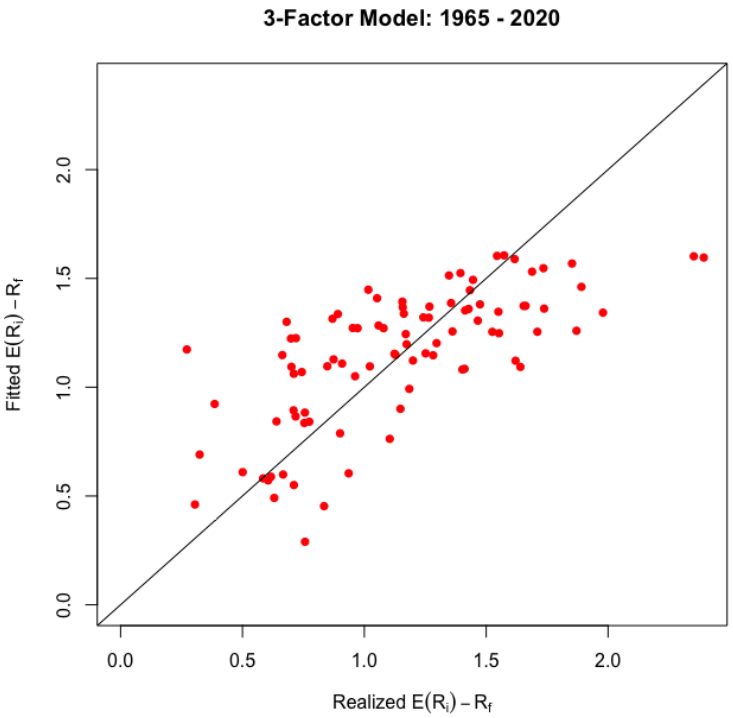
Figure 8. Out-of-sample cross-sectional relationships for the Fama and French three-factor model between average one-month-ahead fitted (predicted) excess returns in percent ( y -axis) and average one-month-ahead realized excess returns in percent ( x -axis): January 1965 to December 2020.